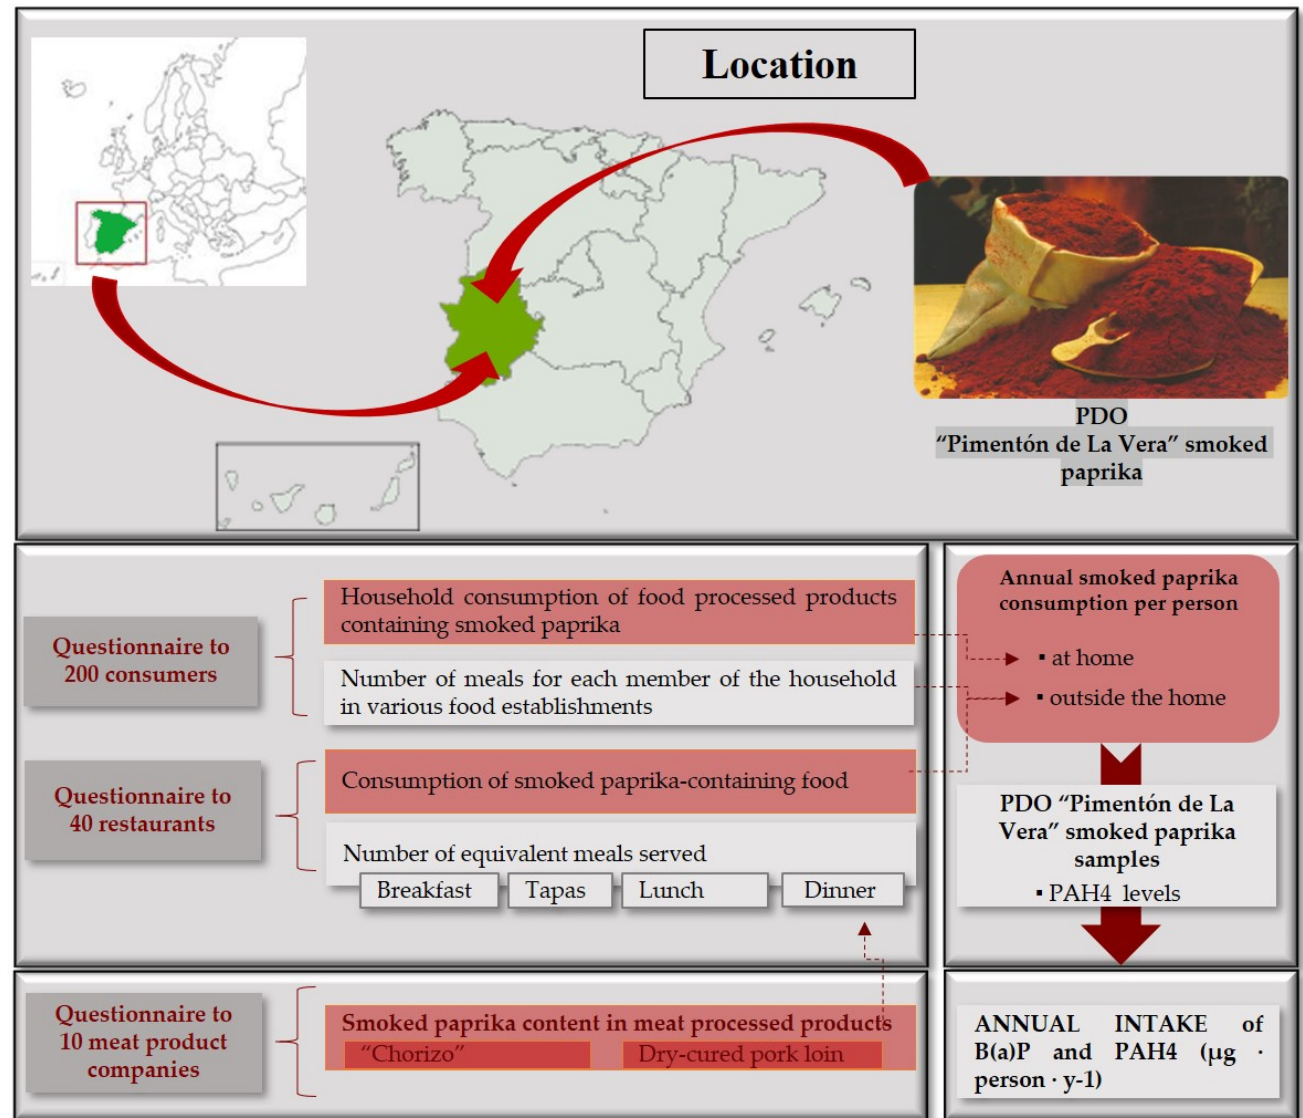
Figure 1. Methodological process. PDO: Protected Designation of Origin.